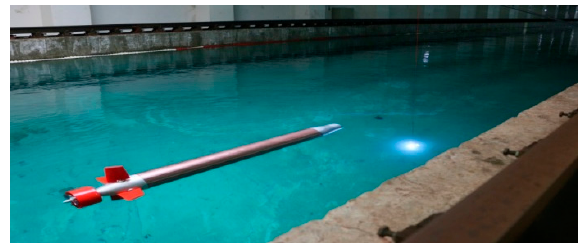
Figure 11. Bigeye Barracuda in fundamental tests.